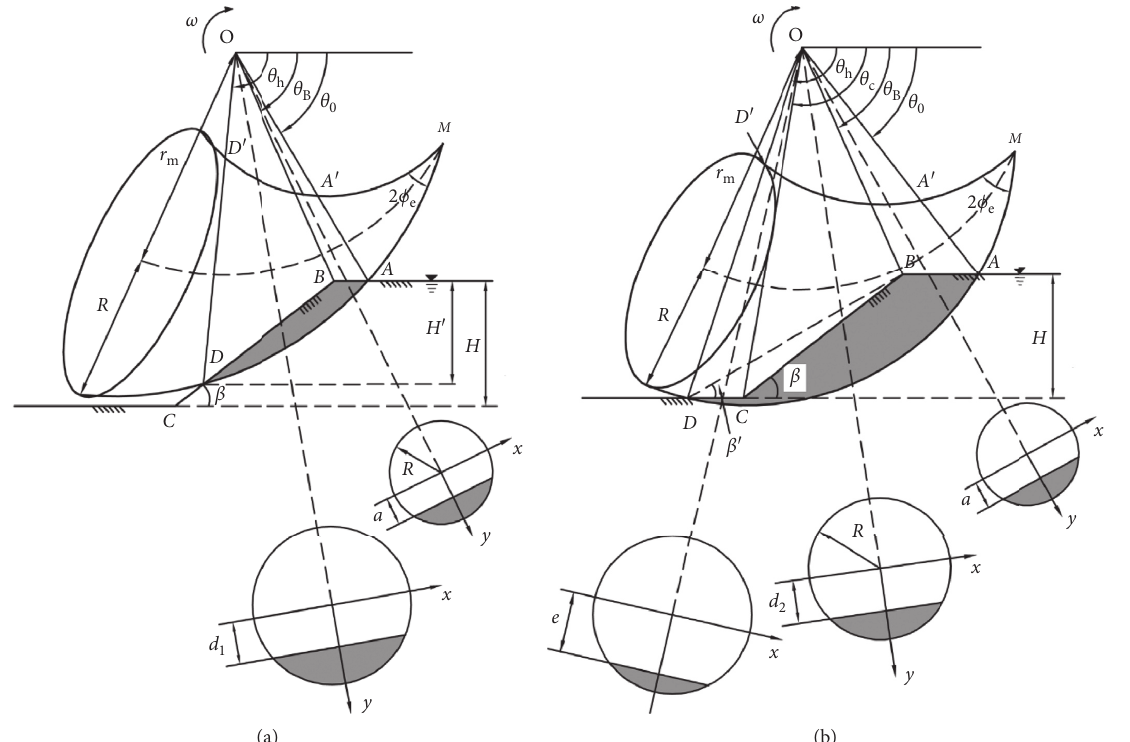
Figure 2: Side view of modified 3D failure mechanisms [3]. (a) Face-failure mechanism. (b) Base-failure mechanism.